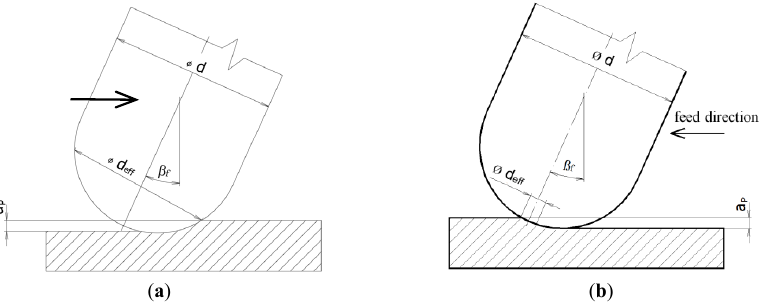
Figure 2. The possibilities of the milling strategy with a tool axis inclination angle [2,14]. ( a ) Tilt in feed direction, ( b ) tilt in pick feed direction (d—tool diameter, a p —axial depth of cut, a e —radial depth of cut, v f —feed direction, β f—tool axis in- clination angle in the feed direction, β n—tool axis inclination angle in the pick feed direction.